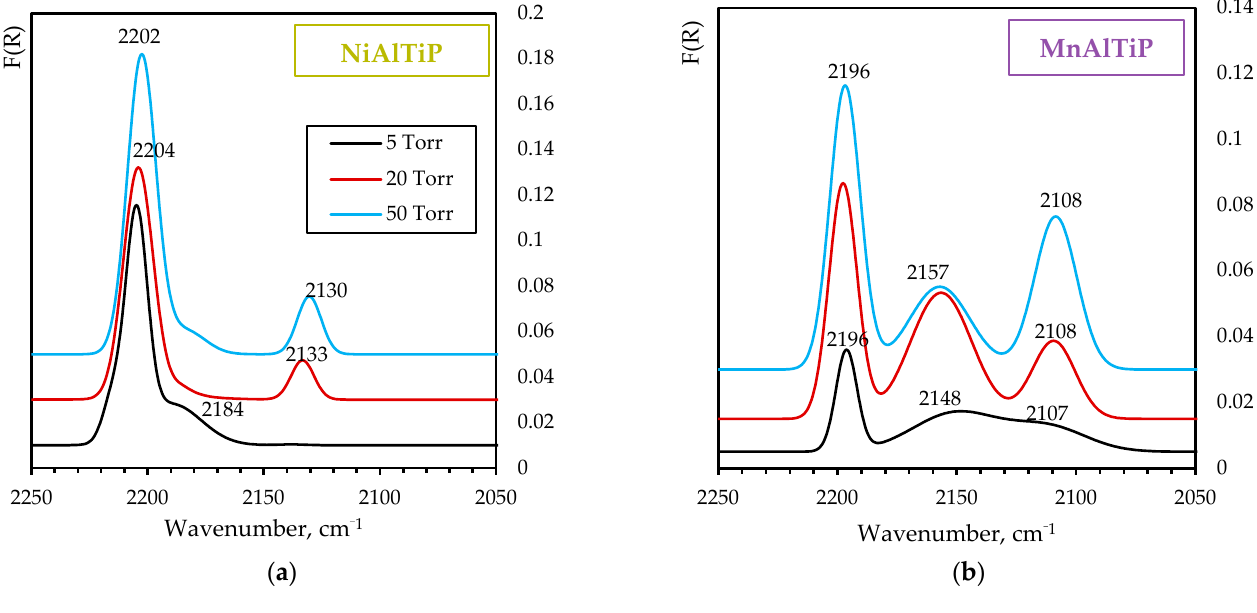
Figure 5. Different diffuse reflectance infrared Fourier transform spectra of adsorbed CO at room temperature and pressure (1) 5 Torr, (2) 20 Torr, (3) 50 Torr. F(R)—Kubelka–Munk function. The FTIR spectrum of CO adsorption on NiAlTiP is the superposition of absorption bands (AB) at 2202–2204, 2184 and 2130–2133 c м − 1 (Figure 5a). The bands at 2202–2204 and 2184 cm − 1 can be attributed to carbonyl species, adsorbed on Ni 2+ cations [36] and associated with carbonyl complexes with the strength-moderate LAS (Lewis acid sites).